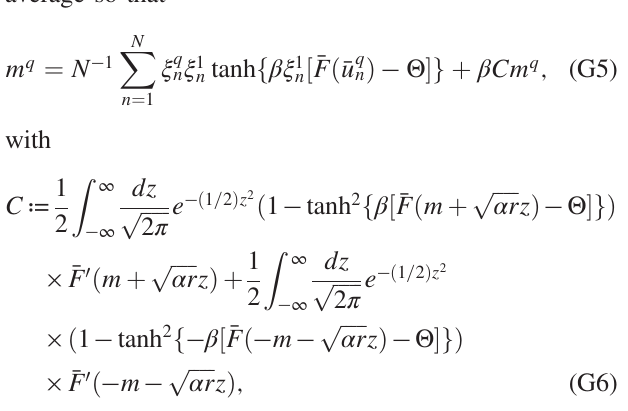
FIG. 13. Critical behavior of the network for a few patterns α ≈ 0 and varying neuronal thresholds Θ and dendritic thresholds θ . Parameters are the same as in Fig. 5, with D ¼ 0 . 4 and different dendritic thresholds θ ∈ f ∞ ; 0 . 1 ; 0 . 05 ; 0 g . Simulation results (circles) and analytical results (dash-dotted lines) for vanishing neuronal thresholds Θ ¼ 0 are compared to the analytical results for Θ ¼ 0 . 4 (solid lines; cf. Fig. 5). θ ¼ ∞ (dash-dotted black and solid gray lines) corresponds to the linear Hopfield model. Decreasing the dendritic threshold θ increases the critical temperature ( θ ¼ 0 . 1 in green and lime lines; θ ¼ 0 . 05 in blue and cyan lines). For θ ¼ 0 (red and orange lines), there is no phase transition anymore, as m ð T Þ asymptotically follows Eq. (H2) (dotted red